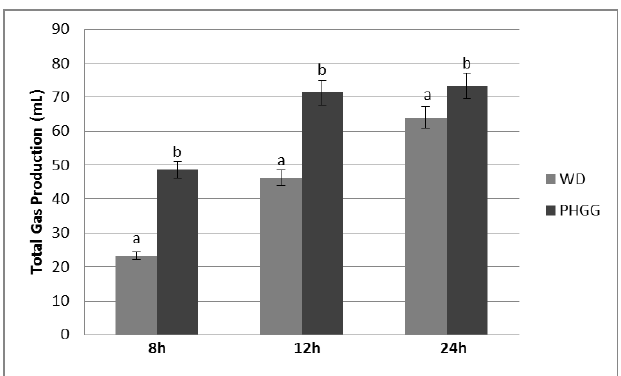
Figure 1. Total Gas Volume Produced in Batch Culture Fermentation System with Wheat Dextrin (WD) and Partially Hydrolyzed Guar Gum (PHGG) Across 24 h of Analysis.